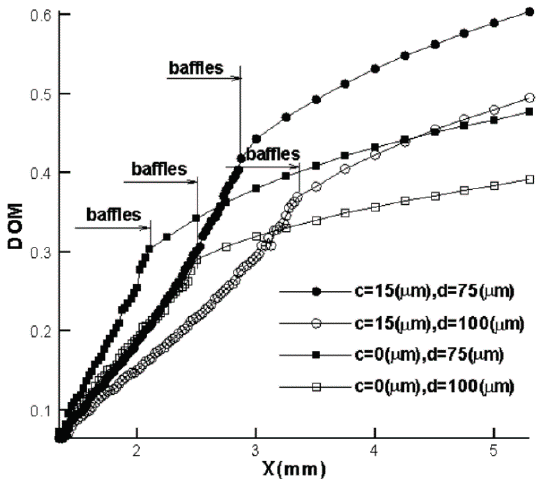
Figure 13. Comparison of the mass fraction distribution in the cross section at 50 μ m downstream of baffles for four different baffle clearances and intervals. ( a ) c = 0 μ m and d = 100 μ m. ( b ) c = 15 μ m and d = 100 μ m. ( c ) c = 25 μ m and d = 100 μ m. ( d ) c = 15 μ m and d = 75 μ m.